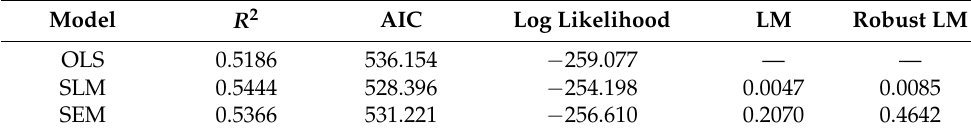
Table 3. Comparison of the OLS, SLM, and SEM models.